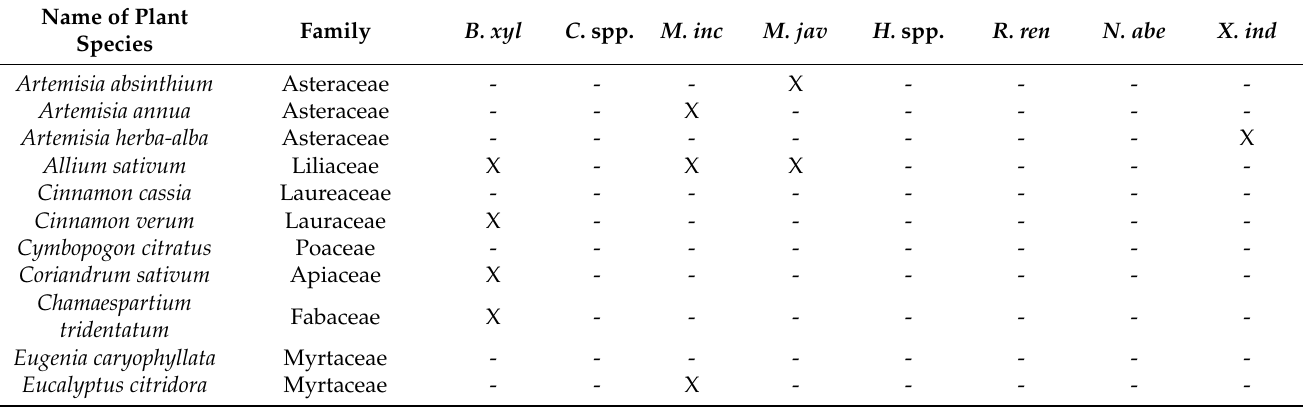
Table 2. Names of plant species from which essential oils (EOs) were extracted and used on nema- todes. The plant family is reported for each EO. The sign “X” indicates a combination between the EO and specific nematode target. The data correspond to the EOs that induced the total mortality (100%) of nematode